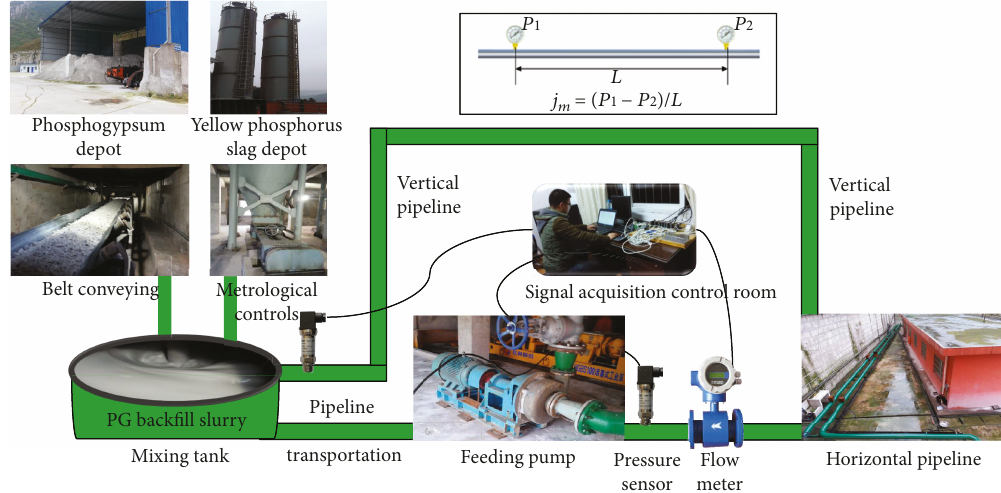
Figure 11: Schematic of the loop test system with several measuring apparatus